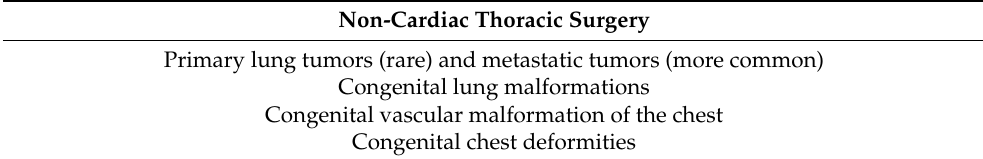
Table 2. Main procedures of non-cardiac thoracic surgery with thoracotomy. Non-Cardiac Thoracic Surgery Primary lung tumors (rare) and metastatic tumors (more common) Congenital lung malformations Congenital vascular malformation of the chest Congenital chest